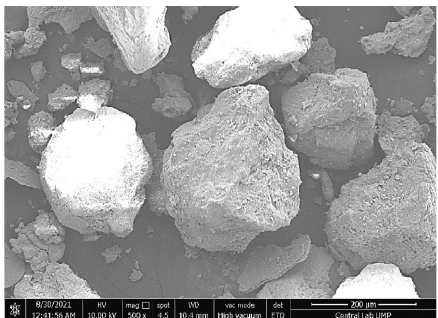
Figure 4: SEM river sand.